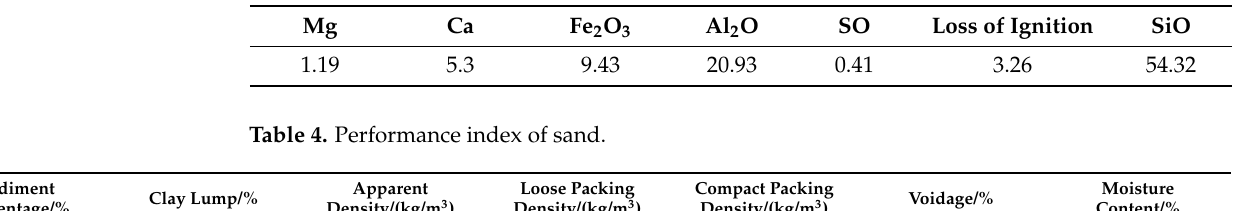
Table 3. Grade I fl y ash chemical composition (%) . Table 3. Grade I fly ash chemical composition (%).